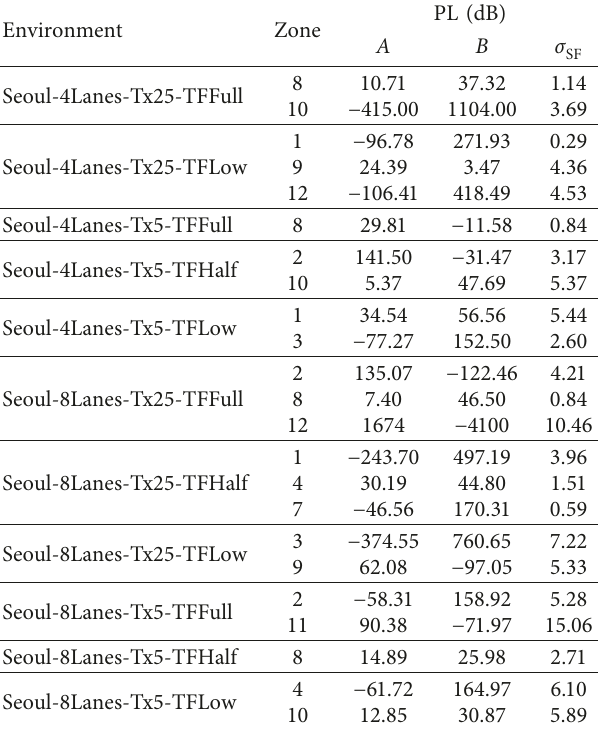
Table 8: Extracted parameters for the DS and K -factor. Environment